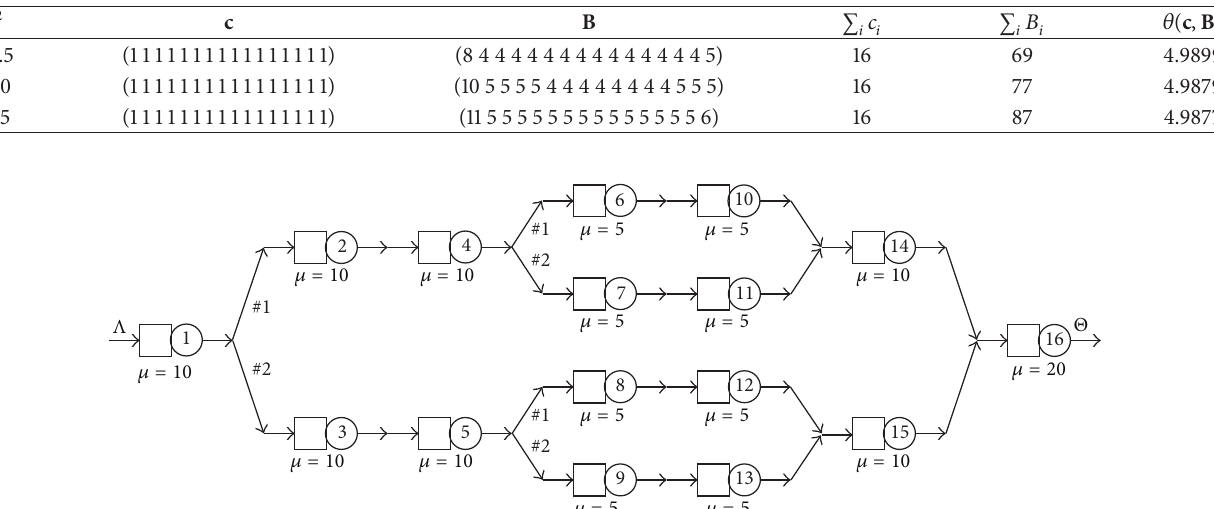
Table 1: Results for the buffer allocation problem (see Smith and Cruz [8]).